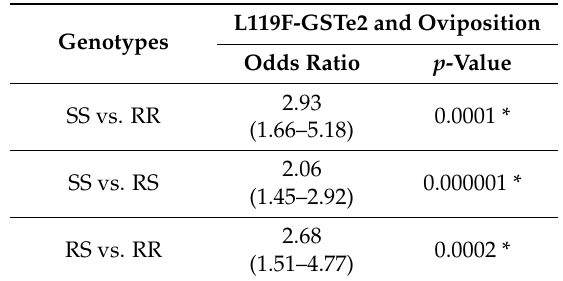
Table 1. Assessment of the association between L119F-GSTe2 genotypes and the ability of females to lay eggs. SS: homozygote susceptible; RR: homozygote resistant; RS: heterozygote; * significant difference p < 0.05.